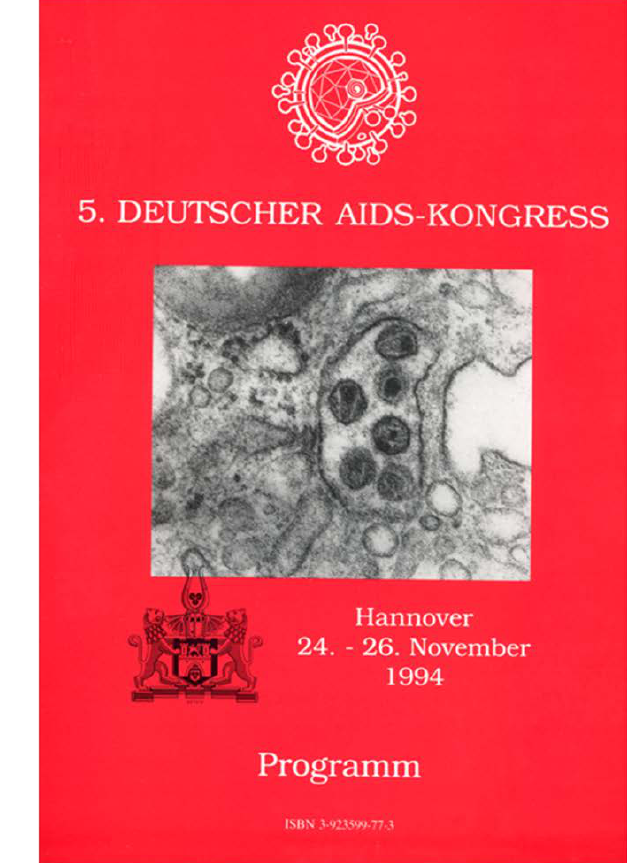
Figure 1. Transmission electron micrograph on the cover page of the program 5th German AIDS congress in Hanover, 1994. The mi- crograph presents an intracytoplasmic vacuole containing SIV par- ticles. The structure was found in an SIV-induced giant cell from an infected rhesus monkey ( Macaca mulatta ). Photo taken by Kaup, Experimental Pathology, German Primate Center.